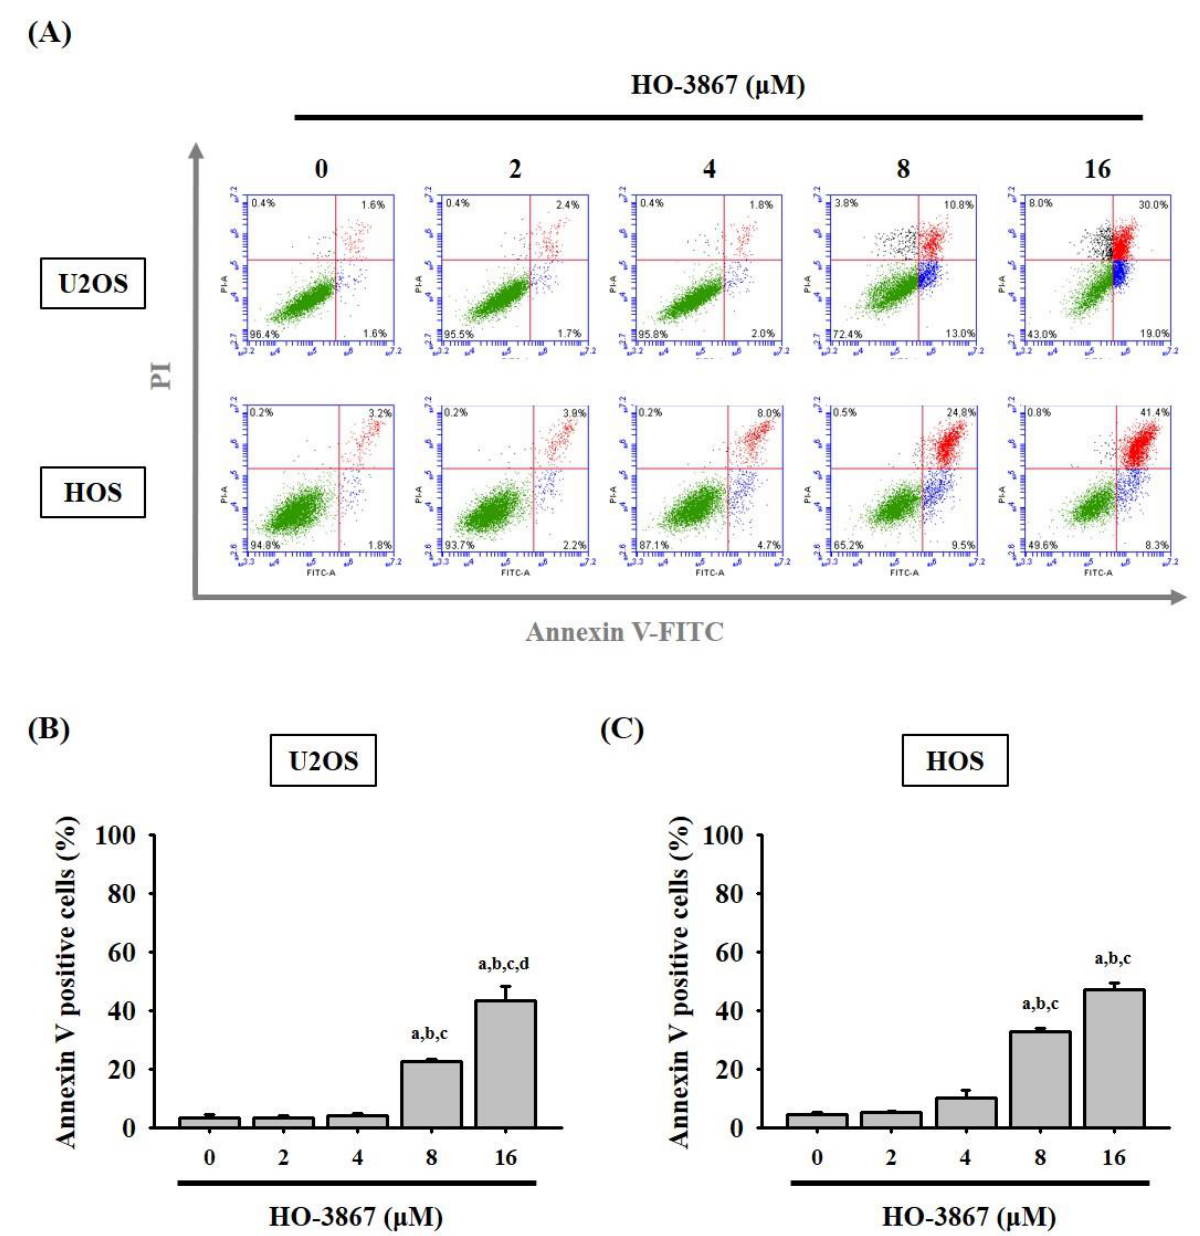
Figure 3. Analysis of cell apoptosis in HO-3867-treated U2OS and HOS cells. ( A ) After treatment with experimental concentration range of HO-3867 for 24 h, Annexin V-FITC/PI staining was performed to analyze DNA contents in U2OS and HOS cells. ( B , C ) The Annexin V-positive cells were subsequently quantified. U2OS: n = 6, F = 355.589, p < 0.001; HOS: n = 5, F = 18.887, p < 0.001. a Significantly different, p < 0.05, when compared to control. b Significantly different, p < 0.05, when compared to 2 μM . c Significantly different, p < 0.05, when compared to 4 μM . d Significantly different, p < 0.05, when compared to 8 μM .